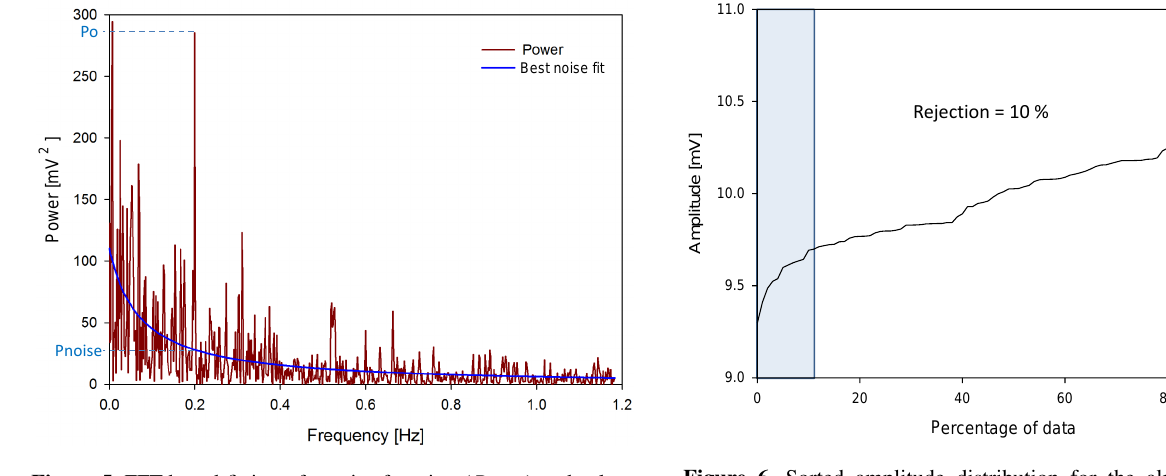
Figure 5. FFT-based fitting of a noise function ( P noise ) and calcu- lation of the signal strength ( P = P o - P noise ) at the first harmonic f = 0.2Hz.